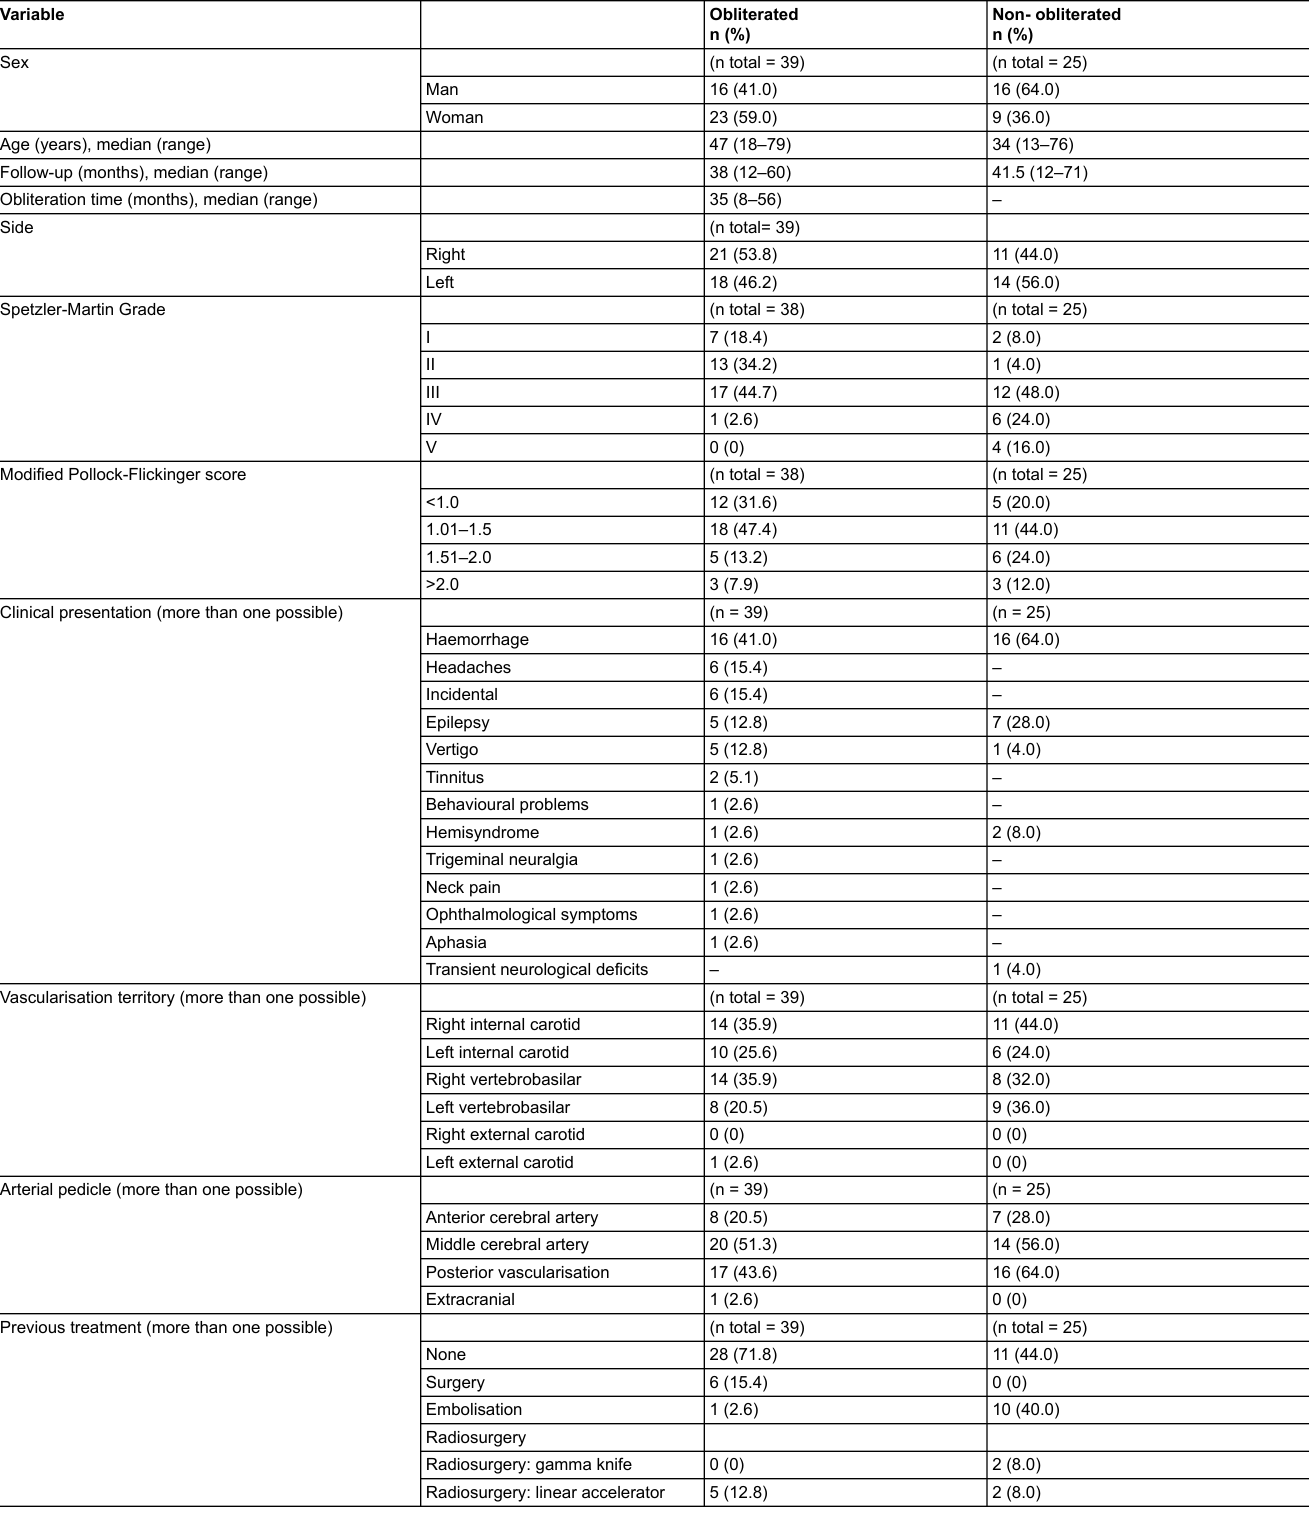
Table 2: Demographic and clinical data after gamma knife treatment: obliterated versus non-obliterated arteriovenous malformations.